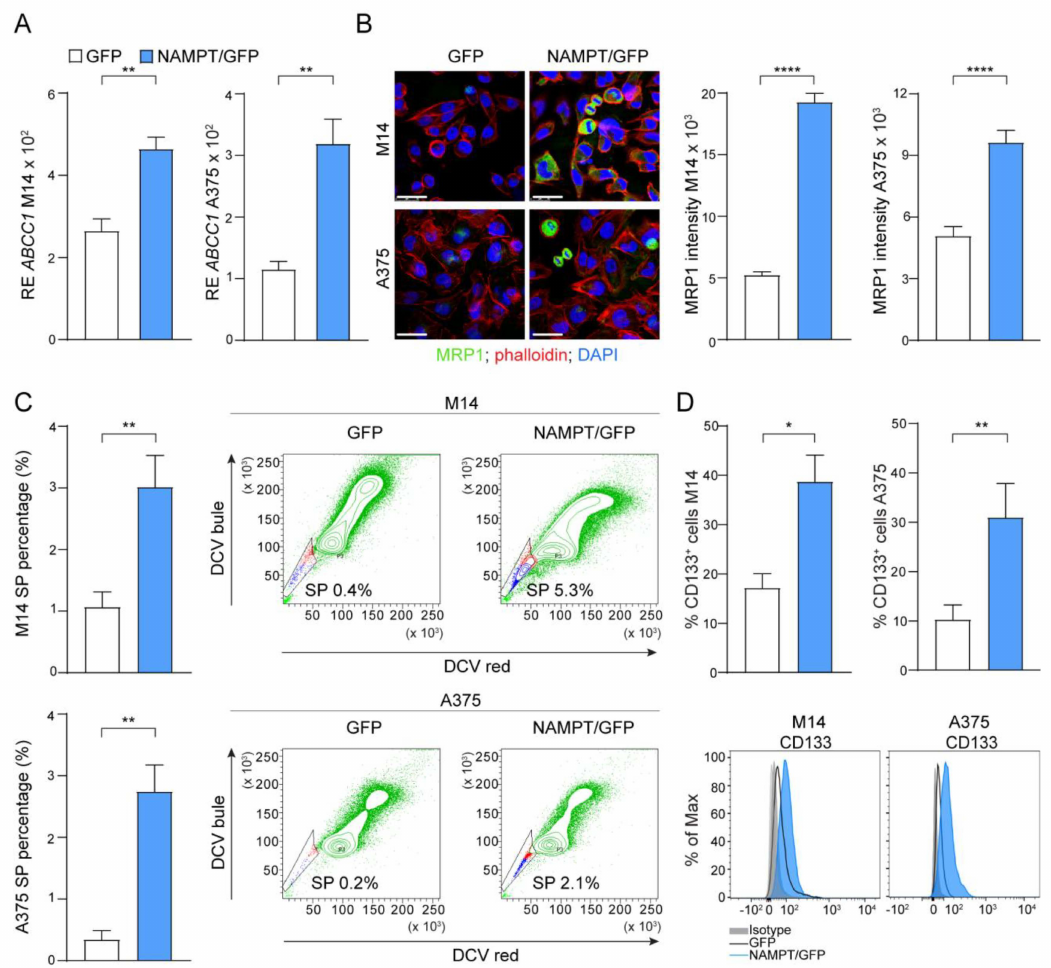
Figure 4. NAMPT over-expression forces stemness properties. ( A ) Histograms reporting cumulative mRNA expression levels of the ATP Binding Cassette Subfamily C Member 1 ( ABCC1 ) in M14 and A375 cell lines comparing NAMPT / GFP and GFP variants. At least 5 independent RT-PCR experiments (Mann–Whitney test). ( B ) Confocal staining for ABCC1 / MRP1 (green fluorescence) in M14 and A375 cell lines comparing NAMPT / GFP and GFP variants (original magnification 63 × , scale bar: 25 µ m). On the right, cumulative data of MRP1 fluorescence intensity measured from at least 3 di ff erent fields of 3 pictures of 3 independent confocal experiments (Mann–Whitney test). ( C ) Histograms showing cumulative results of at least 5 independent experiment to measure the percentage (%) of Side Population (SP) in M14 and A375 variants (Mann–Whitney test). Representative density plots show the increased % SP (the small staminal cell population, highlighted in the gates, that lost dye cycle violet DCV used in FACS staining) in NAMPT / GFP cells compared with GFP. ( D ) Di ff erential expression of the % of CD133 + cells in M14 and A375 NAMPT / GFP and GFP variants detected by FACS analysis (6 independent experiments, Mann–Whitney test). Representative histogram plots are reported below the graphs. Data in the Figure are presented as the mean ± SEM. Significance was represented as: * p ≤ 0.05, ** p ≤ 0.01, and **** p ≤